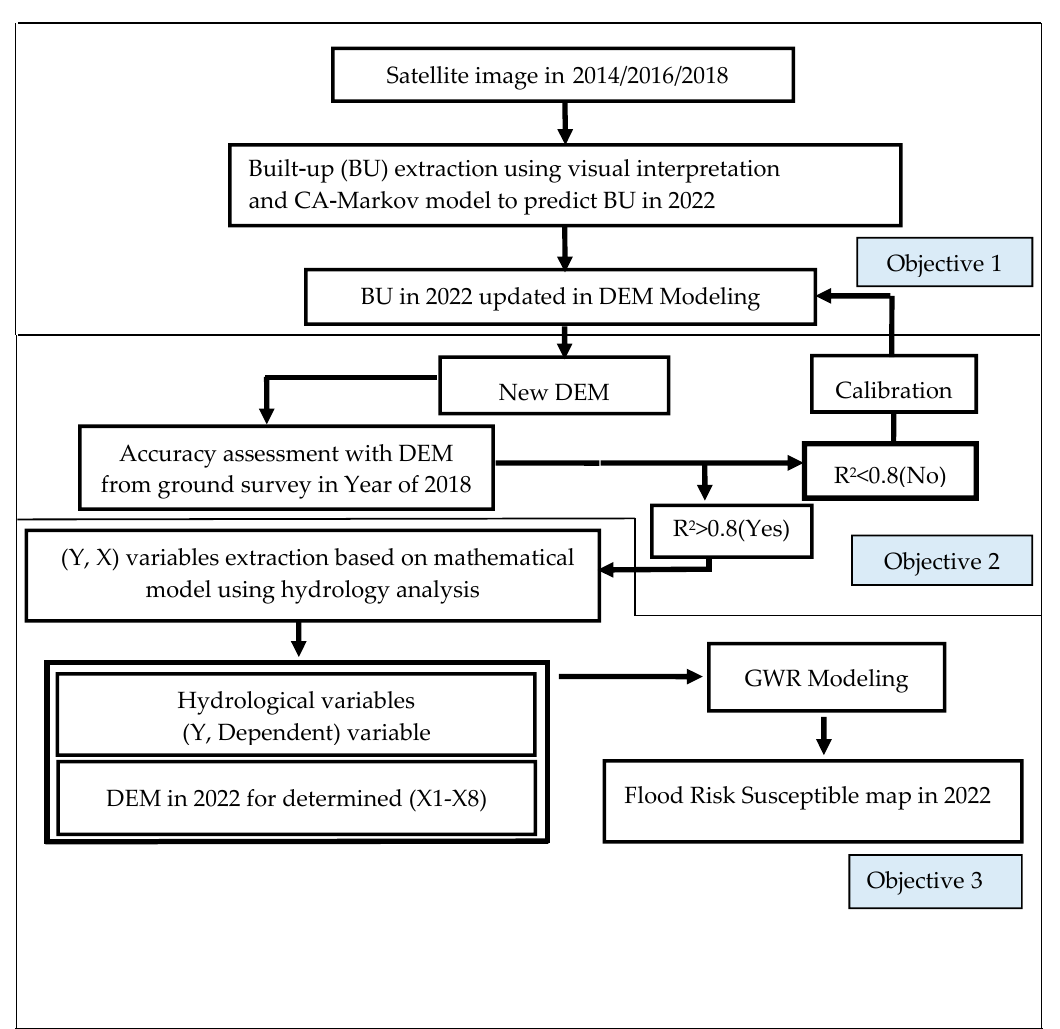
Figure 2. Framework of the study.